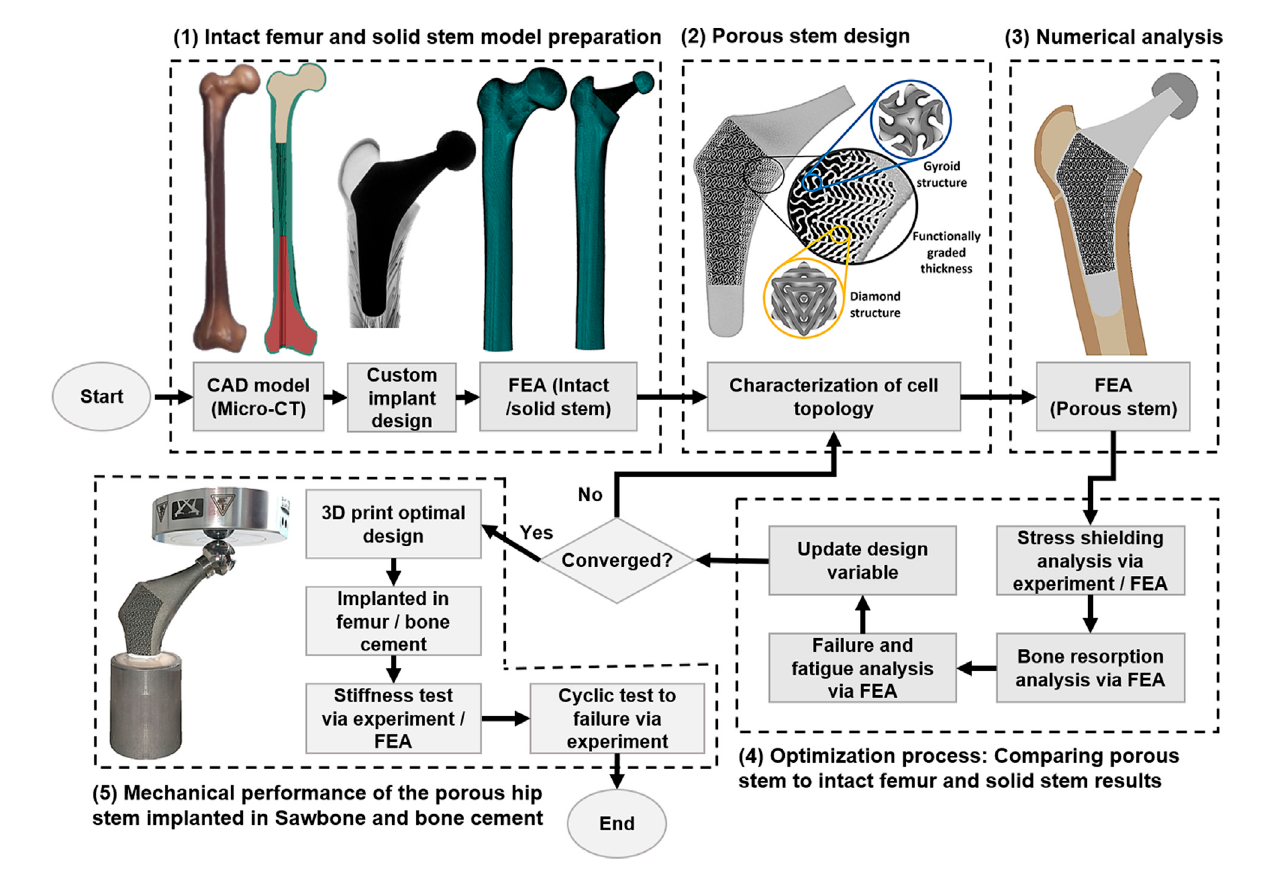
FIGURE 1 Flow chart of porous hip stem optimisation